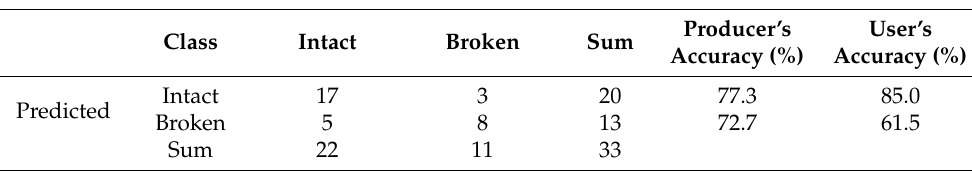
Top predictor variables: LADcv, PTDEN,